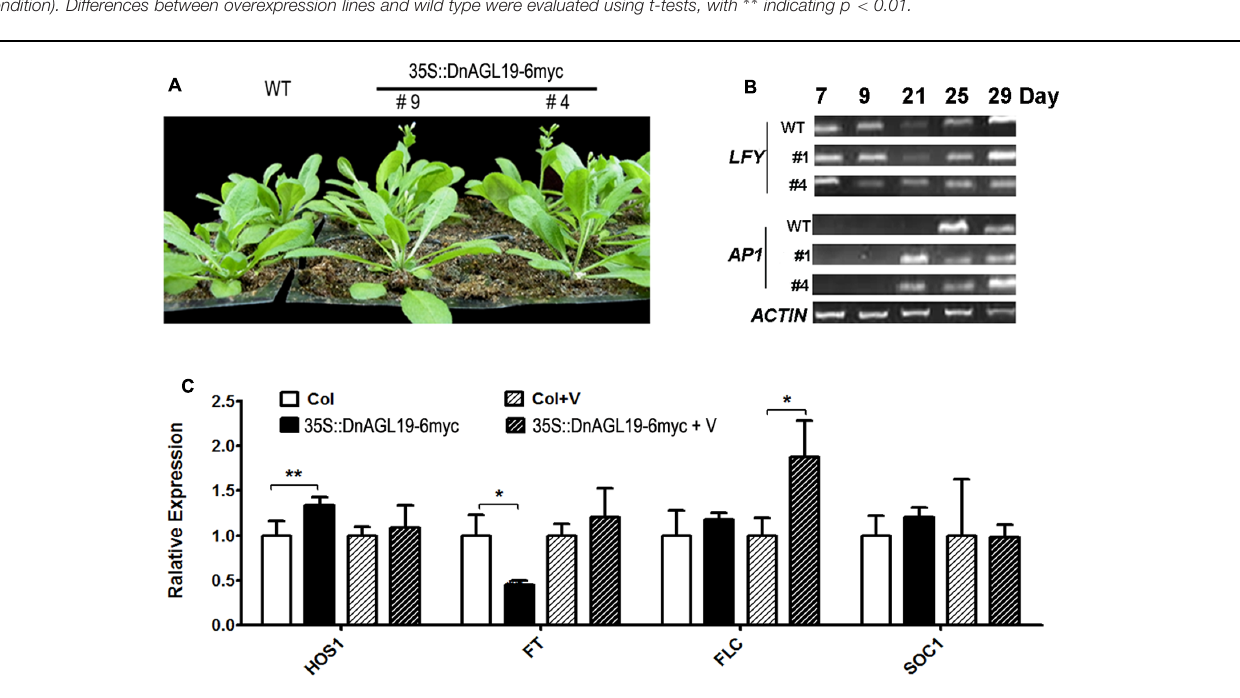
FIGURE 5 | Phenotypes of Arabidopsis thaliana lines overexpressing DnAGL19 . (A) Growth of 25-day old wild type (WT) and DnAGL19 overexpressing lines (35S::DnAGL19-6myc #9 and #4) under normal LD condition. (B) Expression of LFY and AP1 at different developmental stages in wild type and DnAGL19 overexpressing lines (#1 and #4). Total RNA was extracted from seedlings of wild type and the overexpressing lines growing under LD conditions. RT-PCR was carried out. The developmental stages are shown as days after sowing. (C) Expression of flowering time associated genes ( HOS1, FT, FLC, and SOC1 ) in wild type and DnAGL19 overexpressing seedlings before and after vernalization. “N” indicates the non-vernalized plants and “V” indicates the vernalized ones. Total RNA was extracted from 10-day old seedlings. Real-time qPCR was carried out in triplicates for each sample/gene combination, and data are shown as mean ± SD, with ∗ p < 0.05 and ∗∗ p <